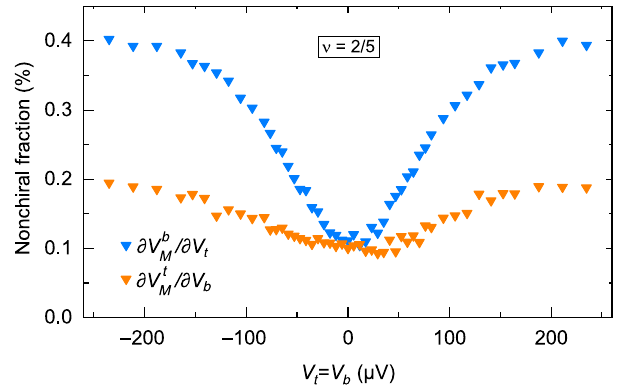
FIG. 13. Nonchiral signal at ν ¼ 2 = 5 . The displayed differ- ential emitted or detected current (voltage) ratios ∂ V t ð b Þ should be null for a perfectly chiral system.